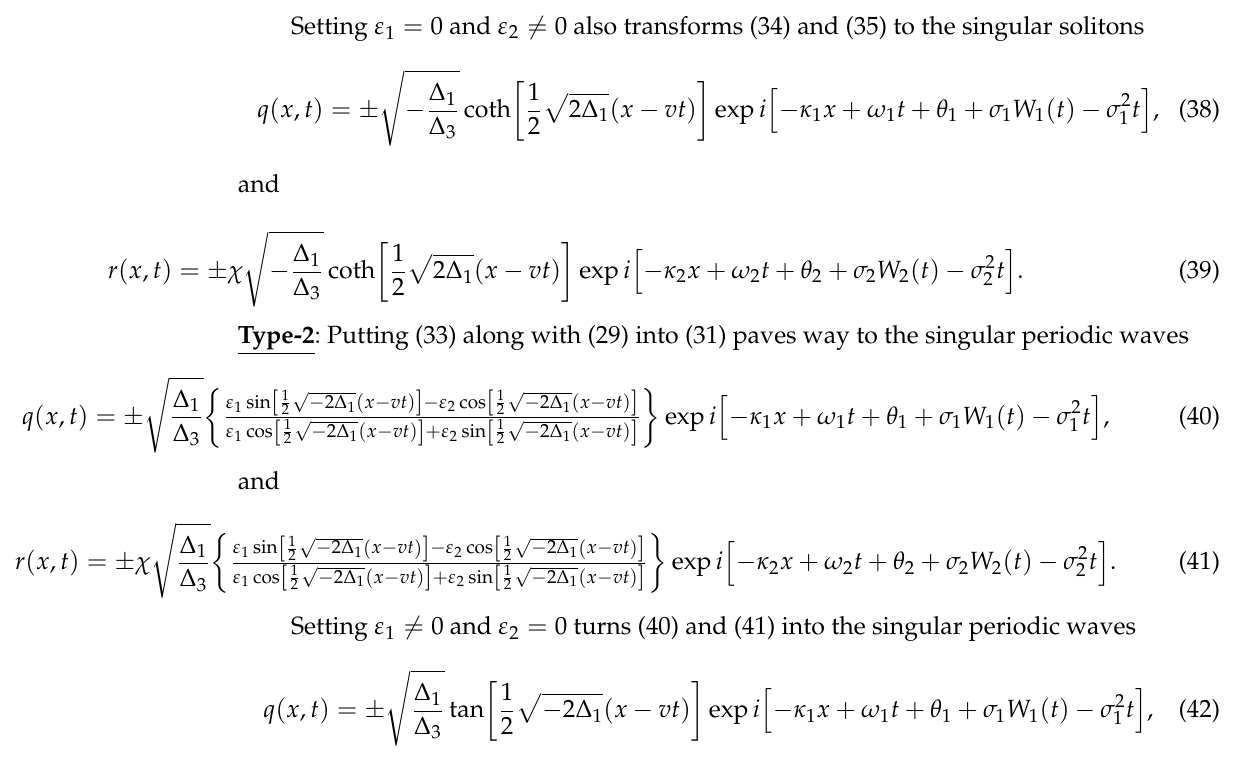
Figure 1. Profiles of dark solitons in birefringent